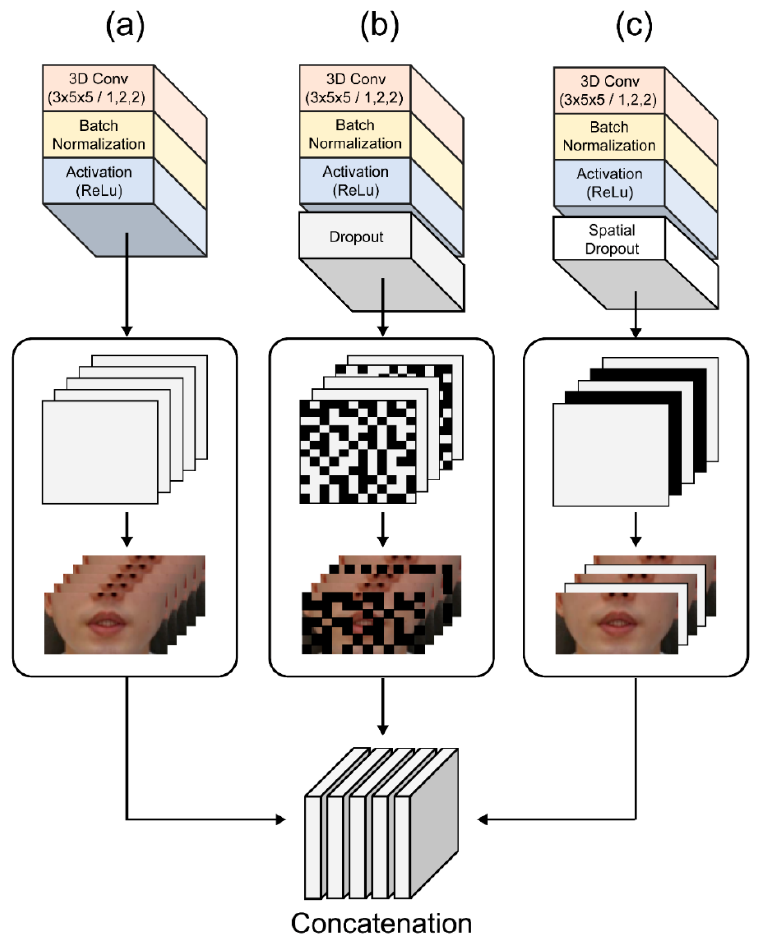
Figure 6. Multilayer 3D CNN architectures: ( a ) first architecture; ( b ) second design with the dropout layer; ( c ) third architecture with the spatial dropout layer.